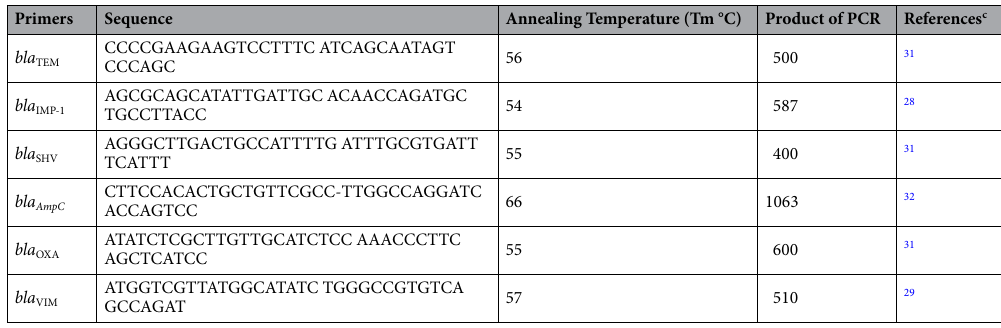
Table 2. Sequence of primers used for detecting MBL a , ESBL b -type variants and bla AmpC. a Metallo β-lactamase, b extended spectrum β-lactamase. c Enlisted in